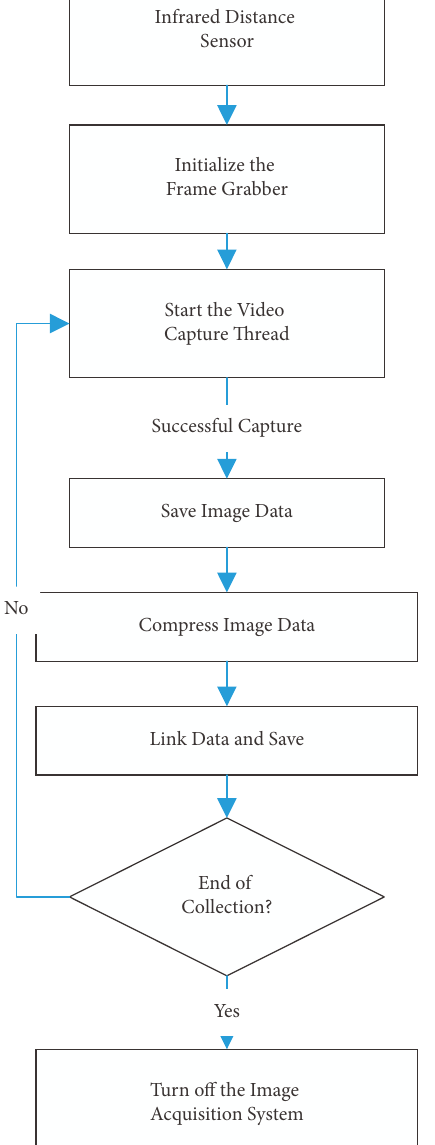
Figure 1: Working principle of system